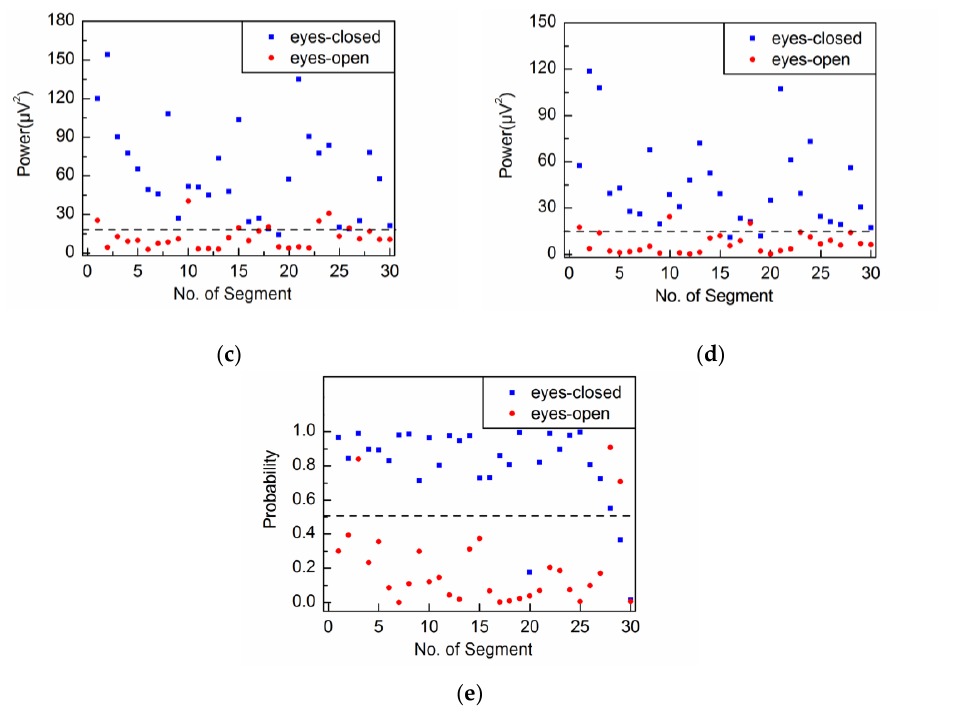
Figure 17. Classification results between eyes-closed and eyes-open states by: ( a ) adaptive SSA; ( b ) WDec; ( c ) IIR; ( d ) SSA#; ( e ) autoregressive model (AR).